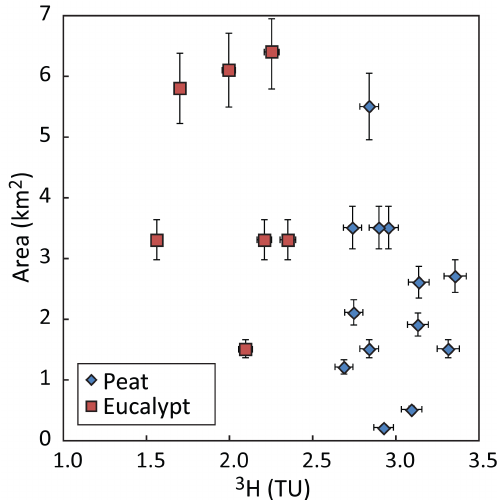
Figure 7. 3 H activities vs. catchment areas for the peatlands and eu- calyptus forest catchments. Area error bars assume a ± 10% mea- surement error; 3 H error bars are from the analytical uncertainties. Data are from Table 1.